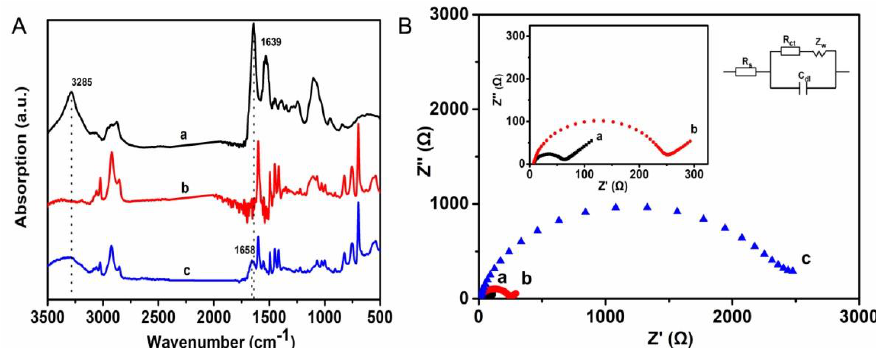
Figure 3. ( A ) The ATR-FTIR spectrum of GOx ( a ), PS- b -P4VPfilm ( b ), and GOx/PS- b -P4VP composite film ( c ); ( B ) Nyquist plots of EIS for bare Pt ( a ), PS- b -P4VP/Pt ( b ), and GOx/PS- b -P4VP/Pt ( c ) in 0.1 M PB containing 0.1 M KCl and 5 mM [Fe(CN) 6 ] 3+ / 4+ for a frequency range of 0.05 Hz to 100 kHz. Inset B : Equivalent circuit applied to fit the impedance spectra.